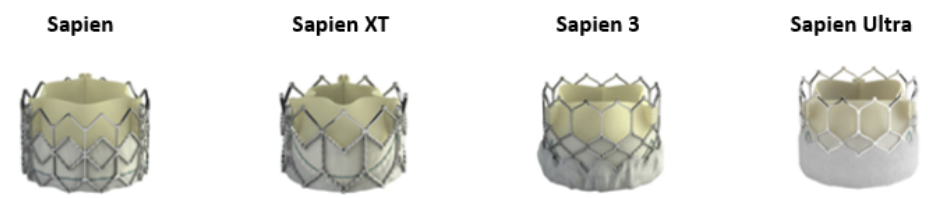
Figure 1. Evolution of the Sapien balloon-expandable valve. The device consists of a trileaflet, bovine pericardial tissue valve mounted on stainless-steel frame. The upper part has an open cell geometry to avoid obstruction and the lower part of the device is covered by a textured sealing polyethylene terephthalate material to reduce paravalvular leak.